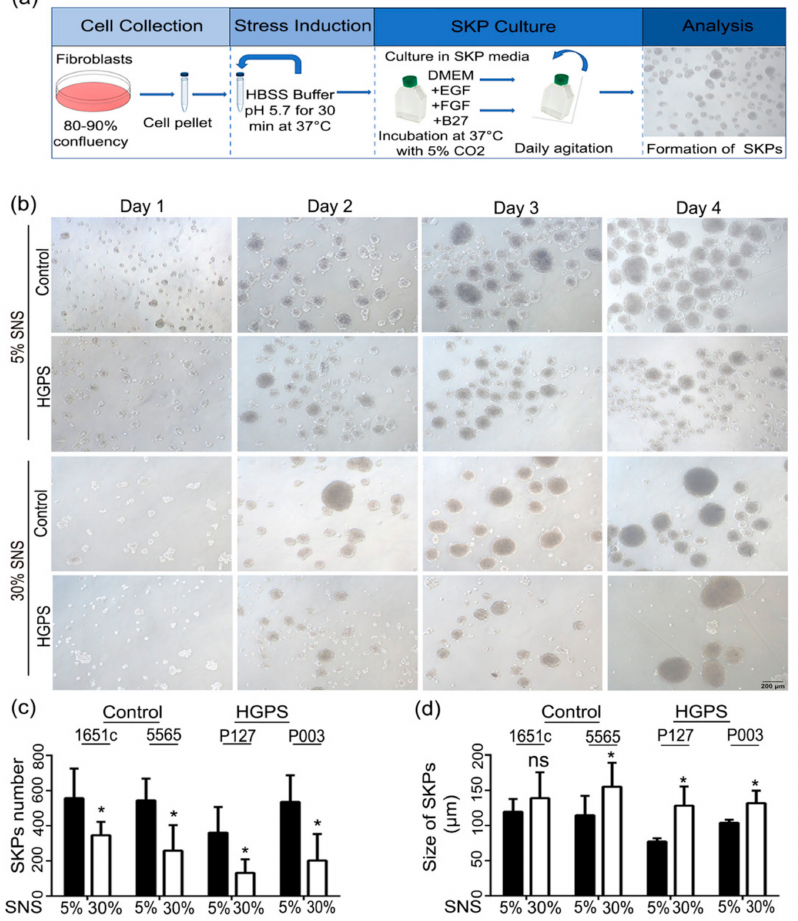
Figure 1. Isolation of SKPs from control and HGPS fibroblasts. ( a ) Panel showing the protocol for SKP isolation. Briefly, fibroblasts were pelleted and treated with HBSS buffer (pH 5.7) for 30 min at 37 ◦ C. Cells were cultured in SKP media containing DMEM low glucose, EGF, FGF, and B27. The flasks were agitated daily, and the spheroids were harvested at day 4 for analysis. ( b ) SKP formation from both control (GMO1651c, GMO5565) and HGPS (HGADFN127, HGADFN003) fibroblasts with 5 and 30% senescence (SNS). ( c , d ) Quantification of the number and the diameter of the spheroids from control and HGPS fibroblast cultures with 5 and 30% SNS at day 4. Values are presented as mean ± SD ( n = 3), not significant (ns), * p < 0.05, ( c , d ) unpaired t -test. HBSS: Hank’s Balanced Salt Solution, DMEM: Dulbecco (cid:48) s modified Eagle medium, EGF: epidermal growth factor, FGF: fibroblast growth factor, SKPs: skin-derived precursor cells, SNS: